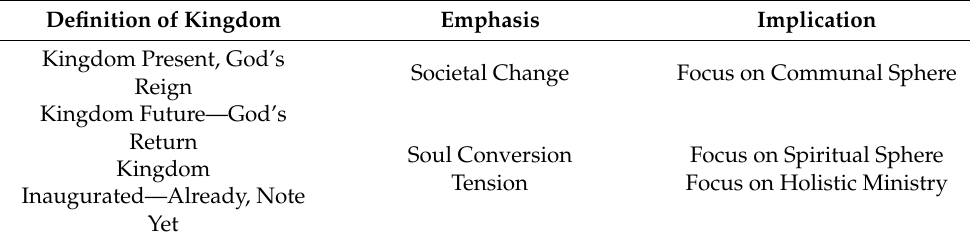
Table 1. Historical implications based on kingdom of God